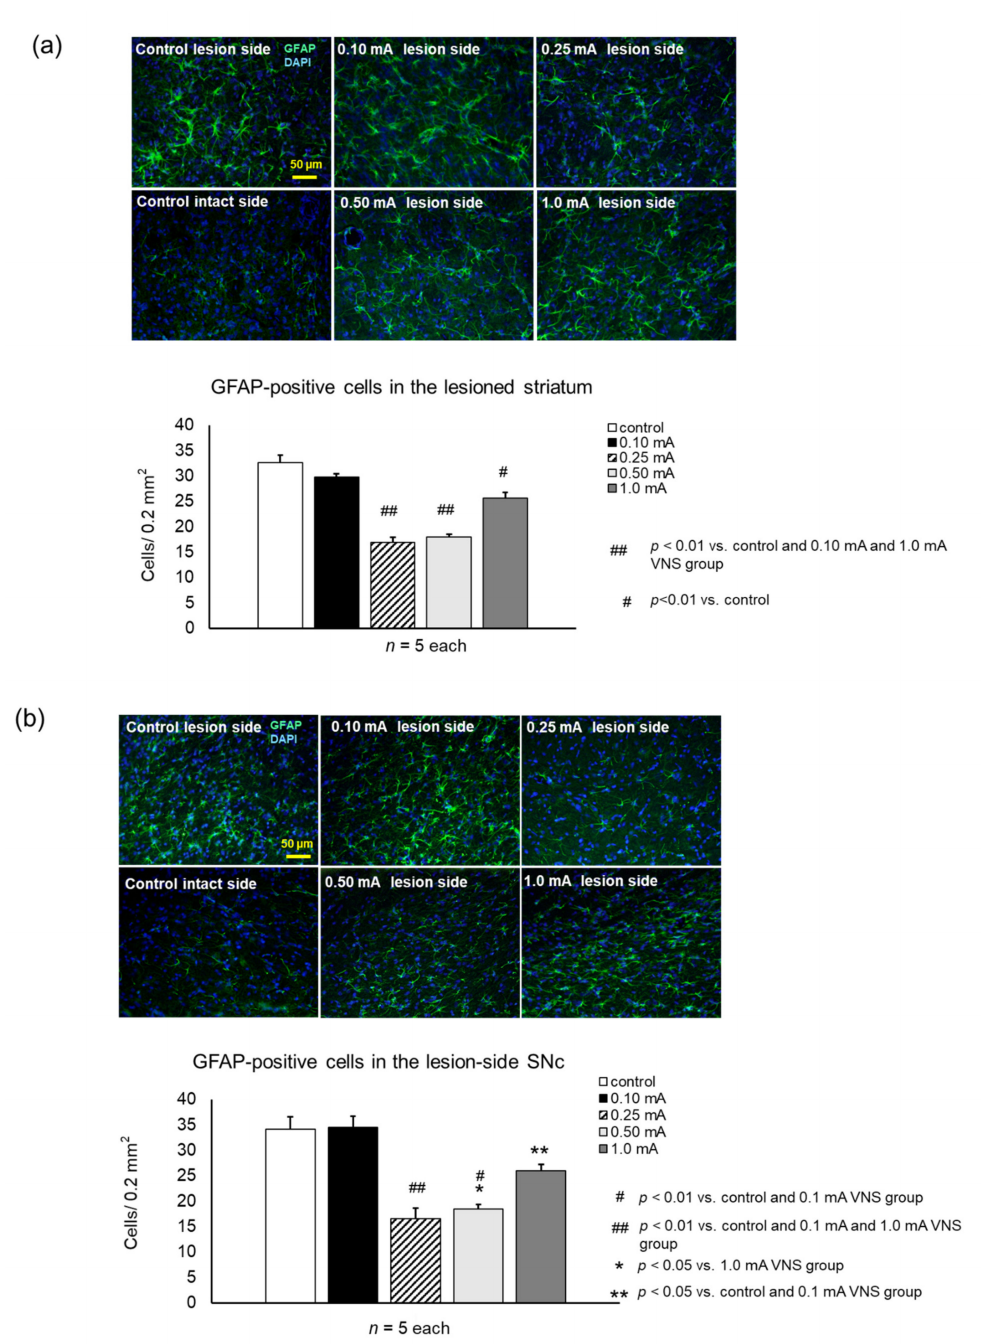
Figure 8. VNS with mild to moderate stimulation intensity inhibited astrocytic proliferation both in the striatum and SNc. ( a ) Glial fibrillary acidic protein (GFAP)-positive astrocytes in the striatum of the lesion side. The number of GFAP-positive astrocytes in the lesioned striatum significantly decreased in the 0.25 mA and 0.5 mA VNS groups to all other groups ( ## p < 0.01). GFAP-positive astrocytes also significantly decreased in the 1 mA VNS group, compared to the control group ( # p < 0.01), although the effect was less than that of the 0.25 mA and 0.5 mA VNS groups. ( b ) GFAP-positive astrocytes in the SNc of the lesion side. The number of GFAP-positive astrocytes in the lesioned SNc significantly decreased in the 0.25 mA, 0.5 mA, and 1 mA VNS groups. Especially, 0.25 mA and 0.5 mA VNS groups displayed remarkable effects. Furthermore, the 0.25 mA and 0.5 mA VNS groups reduced astrocytes compared to all the other groups ( ## p < 0.01 in 0.25 mA VNS group, # p < 0.01 and * p < 0.05 in the 0.5 mA VNS group). The 1 mA VNS group also reduced astrocytes compared to the control and 0.1 mA VNS groups (** p < 0.05). The data are presented as means ± SE and analyzed by one-way ANOVA and Turkey’s post hoc tests. n = 5